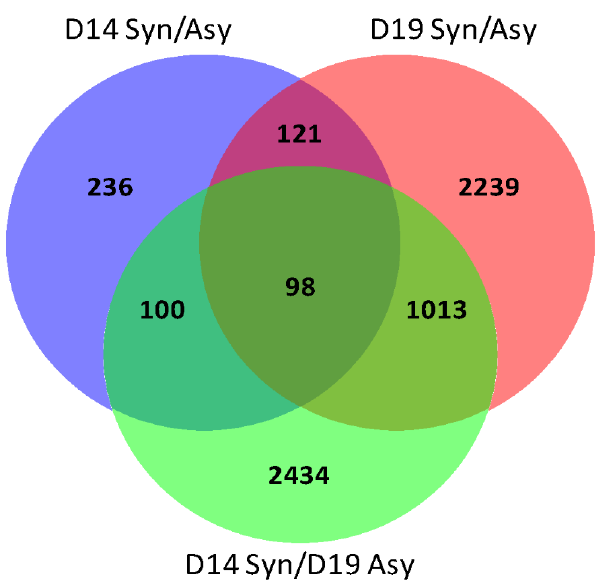
Figure 4. Venn diagram for the overlap of DEGs in equine conceptus membranes between three pair-wise comparisons, day 14 of pregnancy between synchronous (day 14 recipient) and asynchronous (day 9 recipient; D14 syn / asyn) pregnancies, on day 19 of pregnancy between synchronous (day 19) and asynchronous (day 14 recipient; D19-syn / asyn) and between day 14 synchronous day 19 and asynchronous (D14-sync / D19-asyn). The numbers of DEGs in each compartment is depicted.